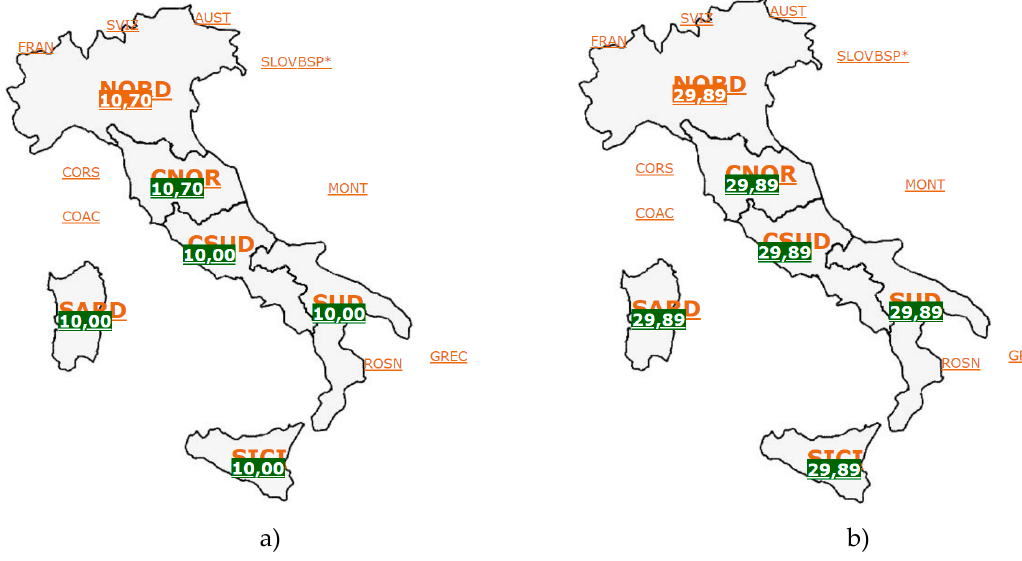
Figure 22. Zonal prices observed in Italy at noon ( a ) and at 19:00 ( b ) of 23rd of March 2020.